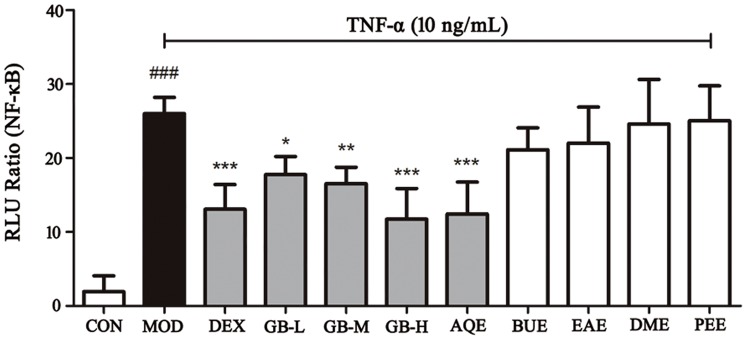
Effects of the extracts from FLJ on NF-κB levels.The values are presented as the means ± SEM; n = 6 for each group. One (*), two (**) or three (***) indicate p<0.05, p<0.01 or p<0.001 vs the TNF-α treated group, respectively; ### indicates p<0.001 vs the control group.